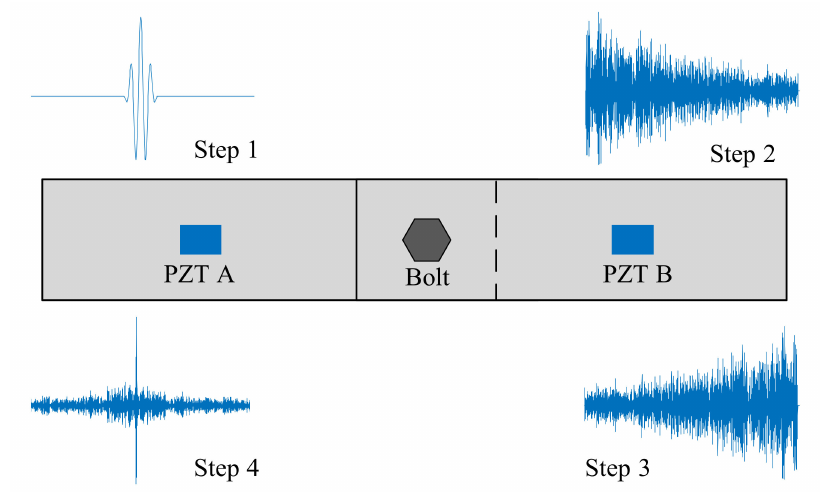
Figure 1. The procedure of the preload monitoring of a bolt lap joint using TR